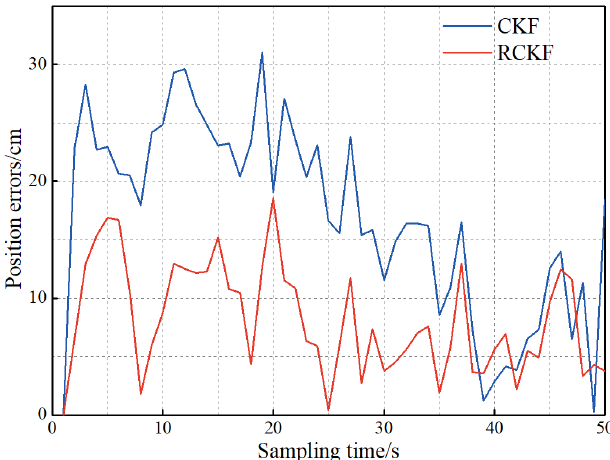
Figure 8. The influence of robust filtering on positioning accuracy.